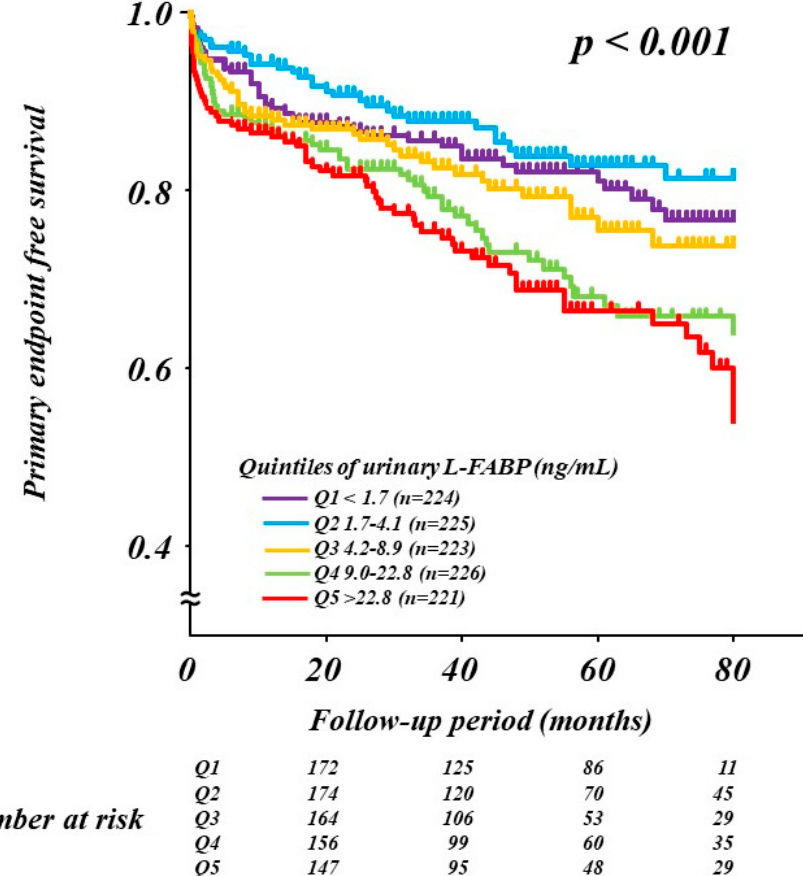
Figure 1. Kaplan–Meier curves for the primary endpoint according to the L-FABP level quintiles. L-FABP, liver-type fatty-acid-binding protein.